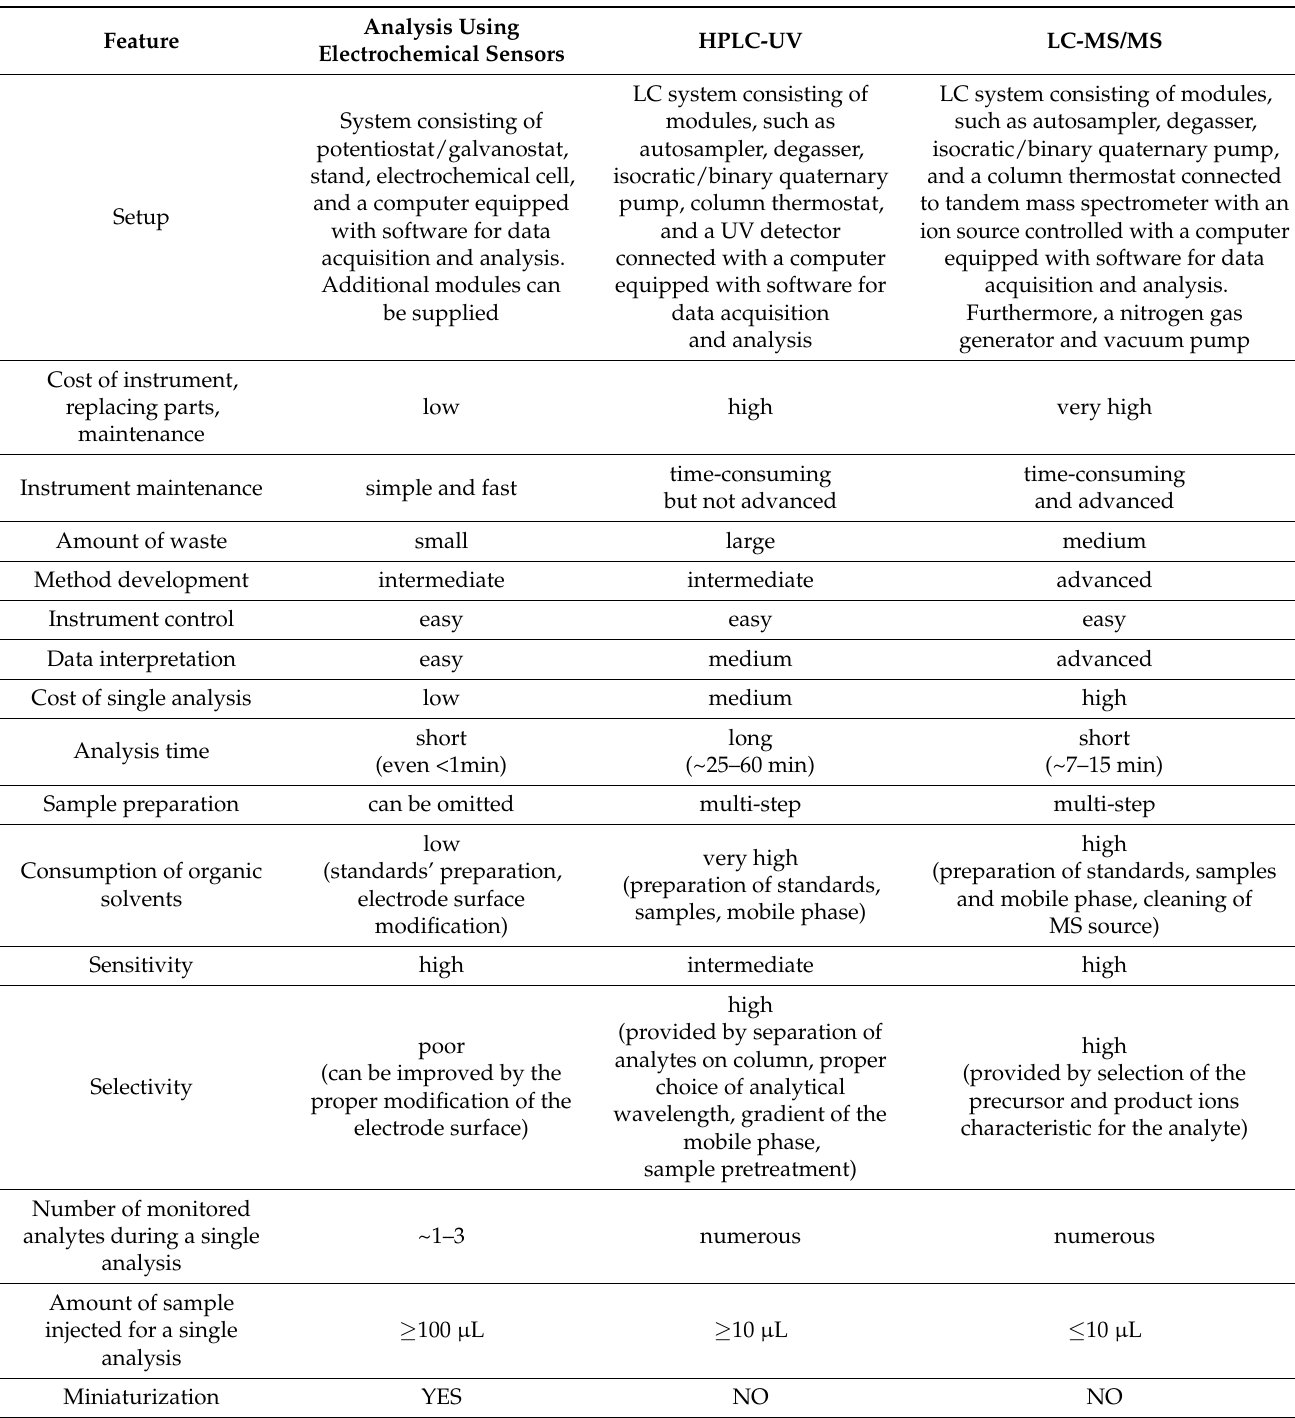
Table 5. Comparison of technical aspects of routine work with electrochemical sensors, LC-MS/MS, and HPLC-UV systems.